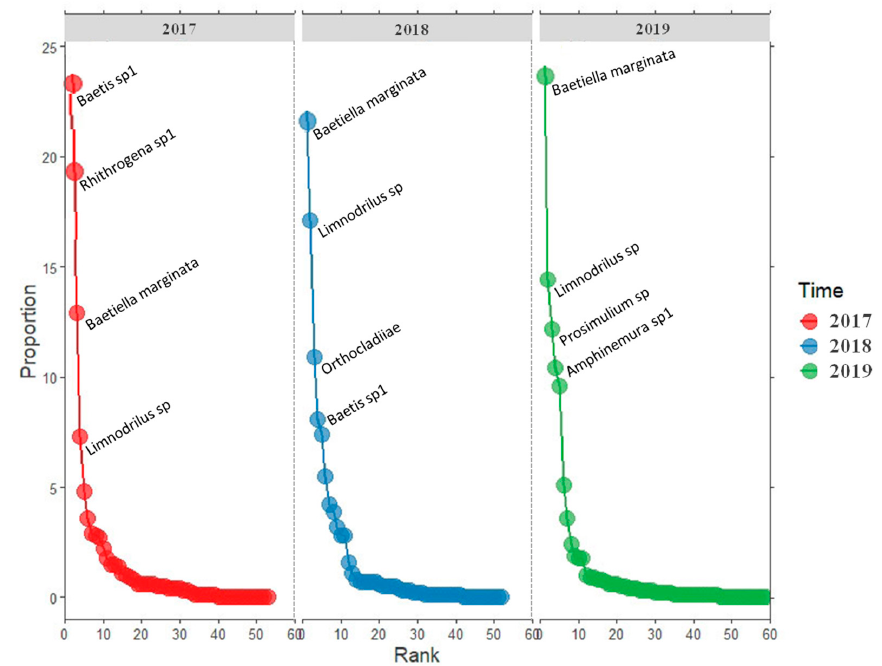
Figure 4. Rank Abundance Curves (RAC) for each of the three analyzed periods represent the most dominant macroinvertebrate taxa. The species name with the codes mentioned in the main text.